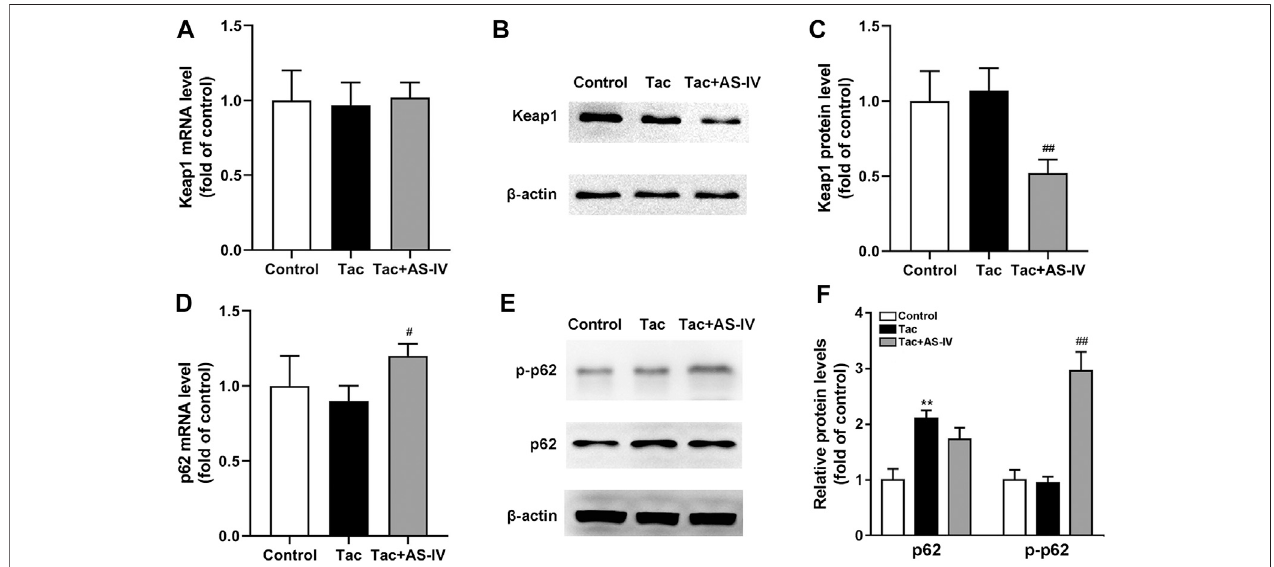
FIGURE6| Astragaloside IVincreasedKeap1degradation andp62phosphorylation invivo .Miceweretreatedwithtacrolimus ± AstragalosideIV for4weeks,and then renal tissues were taken to evaluate the effects of Astragaloside IV on the Keap1 mRNA levels ( n (cid:1) 8) (A) , the Keap1 protein levels ( n (cid:1) 6) (B) – (C) , the p62 mRNA levels ( n (cid:1) 8) (D) and the p62 as well as phosphorylated p62 protein levels ( n (cid:1) 6) (E – F) . ** p < 0.01 vs. the Control group; # p < 0.05 and ## p < 0.01 vs. the Tac